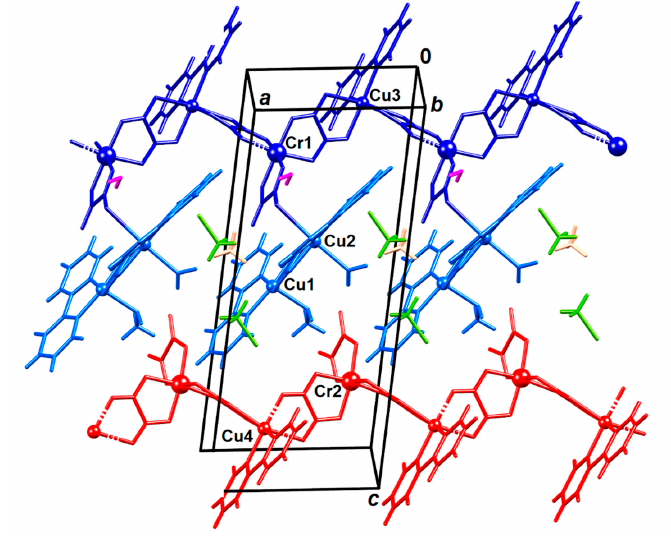
Figure 2. Crystal structure of compound 2 . Symmetry-inequivalent molecules are colour-coded: chain Cr1–Cu3 is dark blue and its pendant dimeric unit Cu1–Cu2 is light blue, the Cr2–Cu4 chain is red, the uncoordinated water molecule is magenta, methanol is green and acetonitrile is orange.